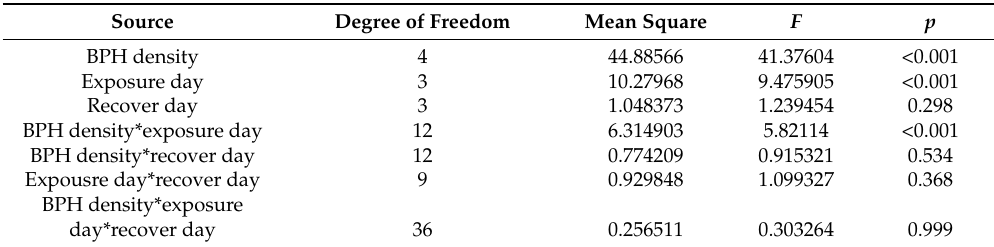
Table 1. Effects of BPH density, exposure day, and recover day on the RVI 760/674 from a rice plant based on a repeated measure ANOVA.